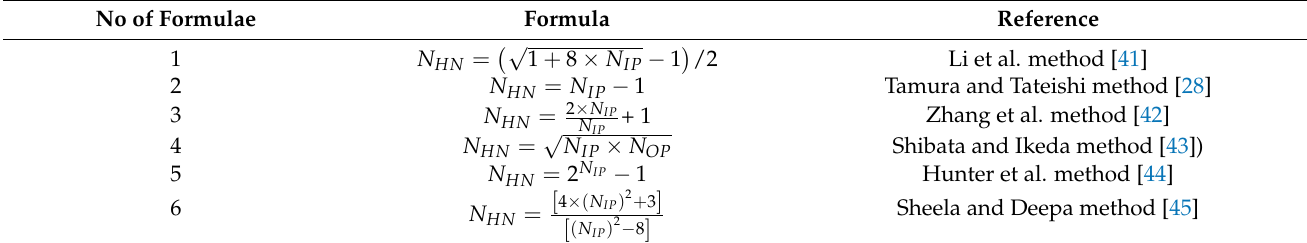
Table 1. Formulae for estimating the number of hidden neurons (Wu et al., 2021) [18]. No of Formulae Formula Reference